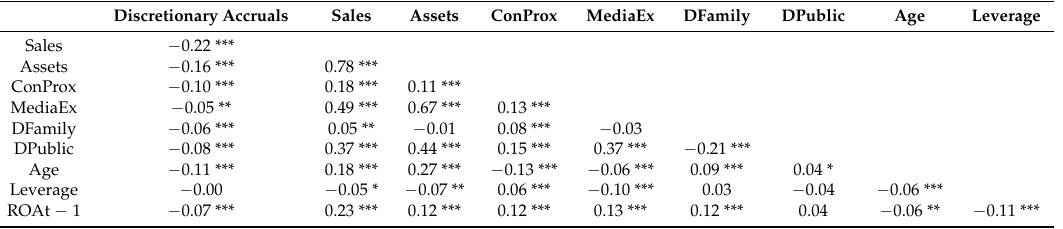
Table 2. Correlations.